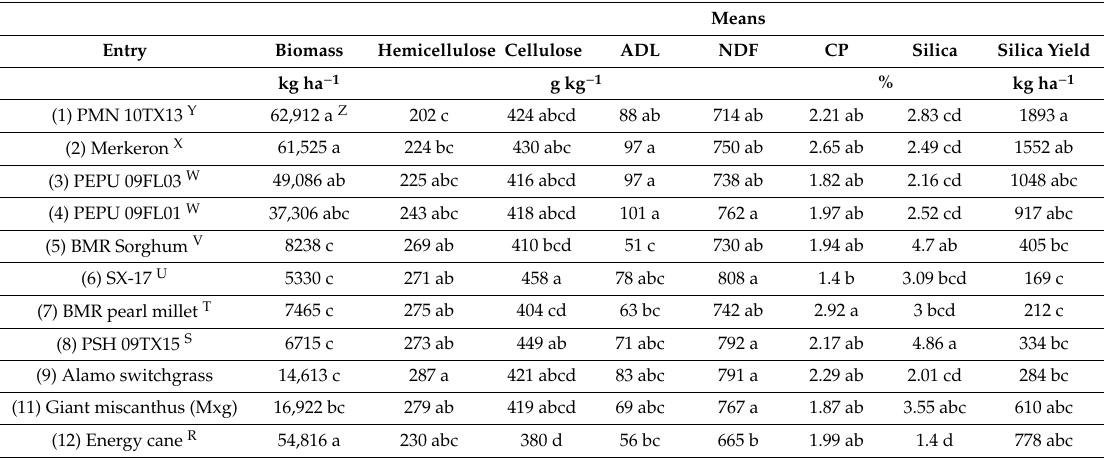
Table 7. Second year College Station sample traits of biomass yield (kg ha − 1 ) and chemical composition including hemicellulose, cellulose, acid detergent lignin (ADL), neutral detergent fiber (NDF) (g kg − 1 biomass), crude protein (CP) (%), silica (%), and silica yield (kg ha − 1 ). Means Entry Biomass Hemicellulose Cellulose ADL NDF CP Silica Silica Yield kg ha − 1 g kg − 1 kg ha −